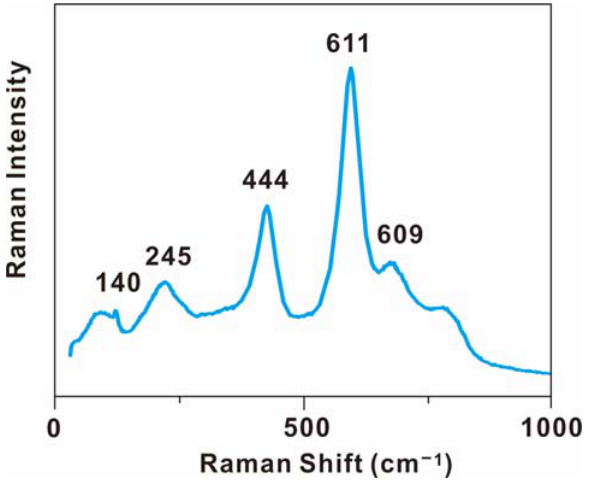
Figure 3. Representative Raman spectrum of rutile inclusion (Ru-1).